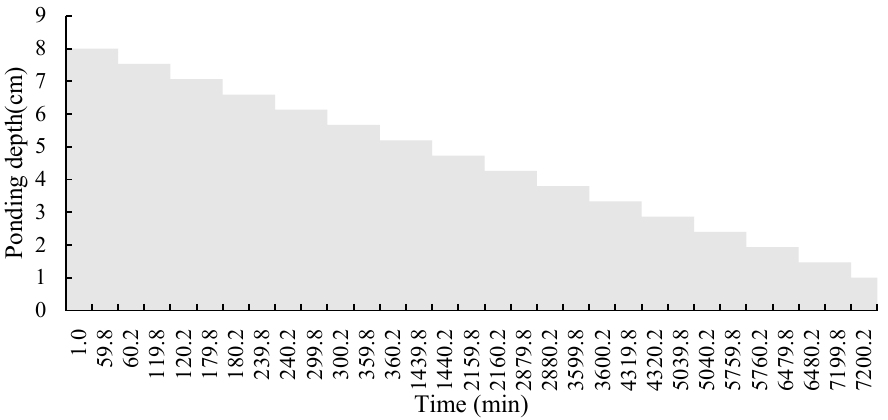
Figure 2. Ponding depth of surface boundary.